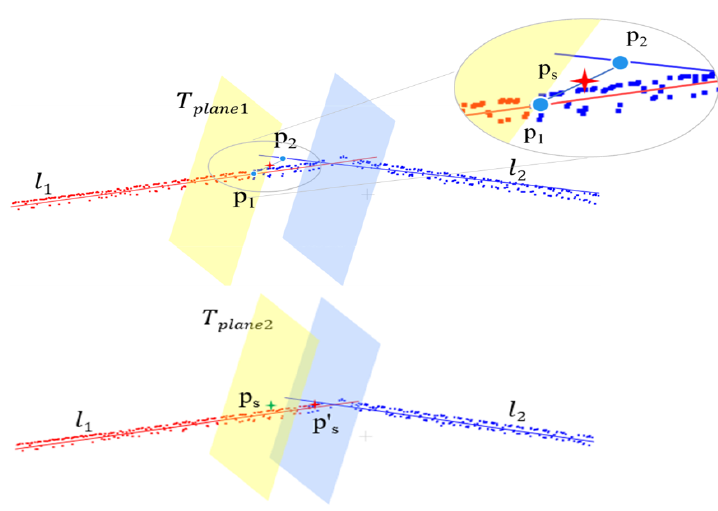
Figure 12. Suspension points location under the guidance of